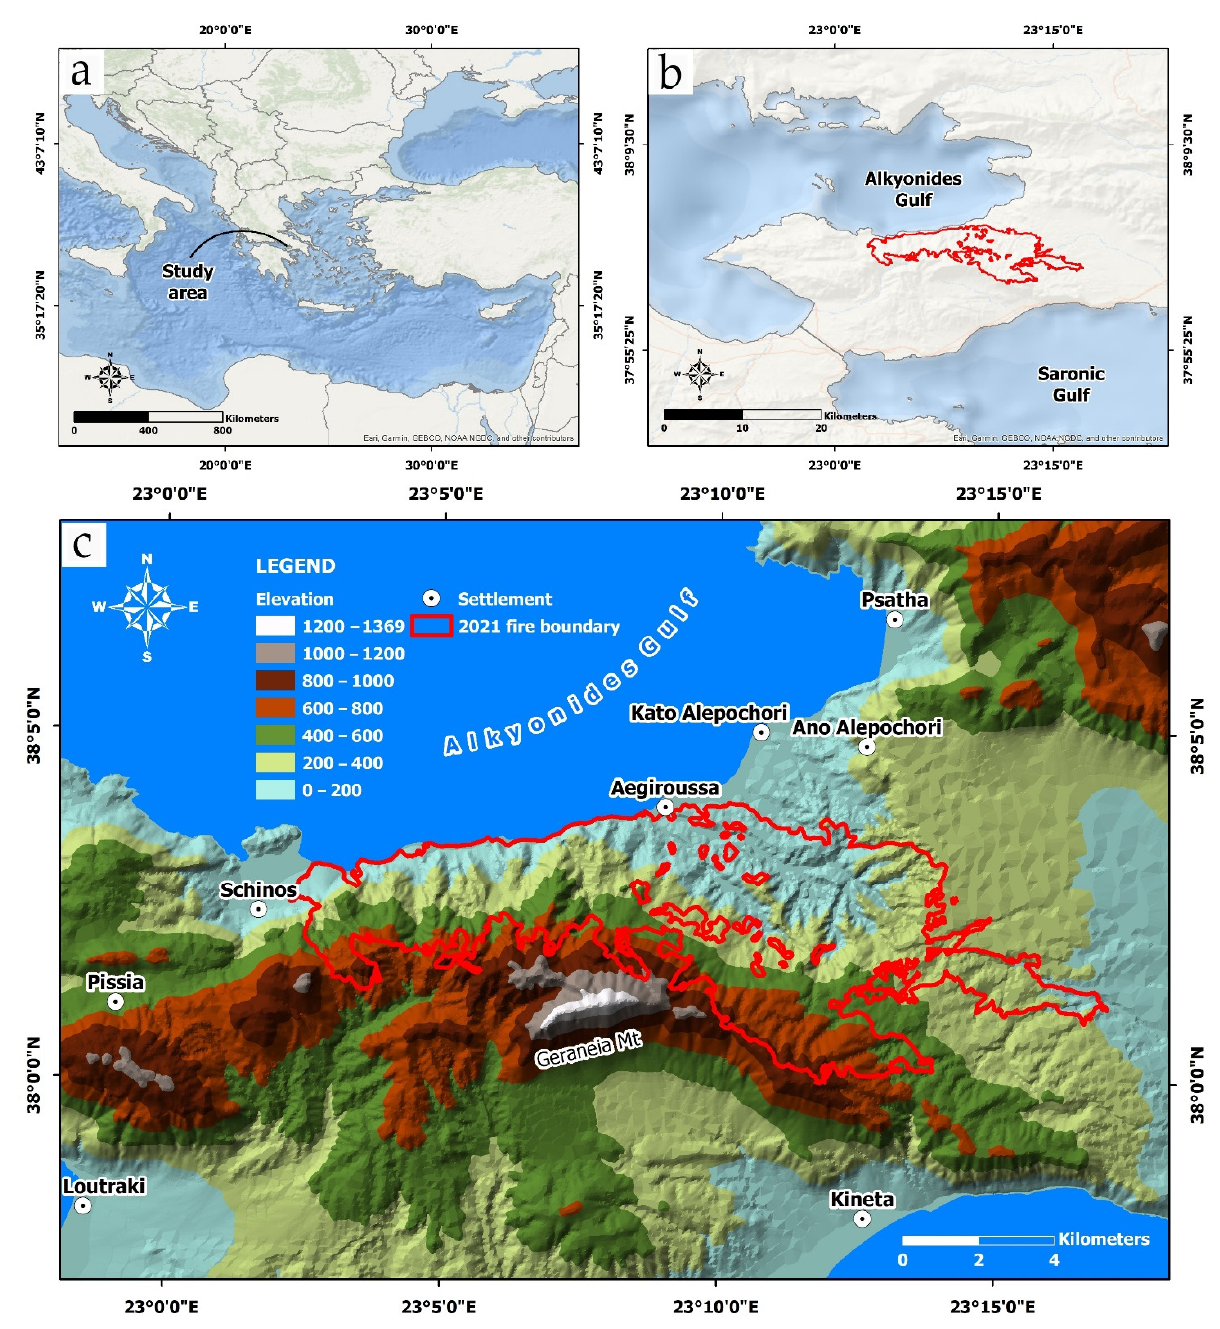
Figure 1. Map of the study area showing ( a ) its general location in the Eastern Mediterranean, ( b ) its position between the Alkyonides and the Saronic Gulf in Greece, and the boundary of the May 2021 fire (red-colored line), and ( c ) the main settlements and elevation in relation to the extent of the 2021 fire.